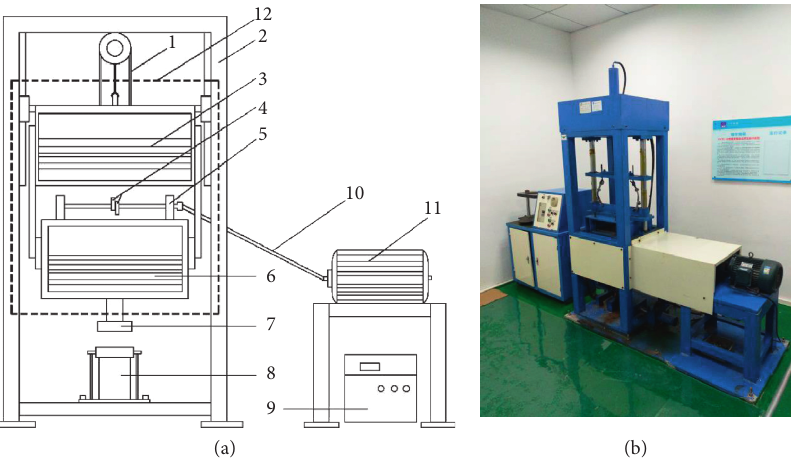
Figure 2: VVTE schematic: (a) diagram of VVTE: (1) lifting system; (2) frame; (3) upper system; (4) eccentric block; (5) rotation axis; (6) lower system; (7) vibratory hammer; (8) test mold; (9) control system; (10) rotation axis; (11) electric motor; (12) vibration system. (b) Photograph of VVTE in the